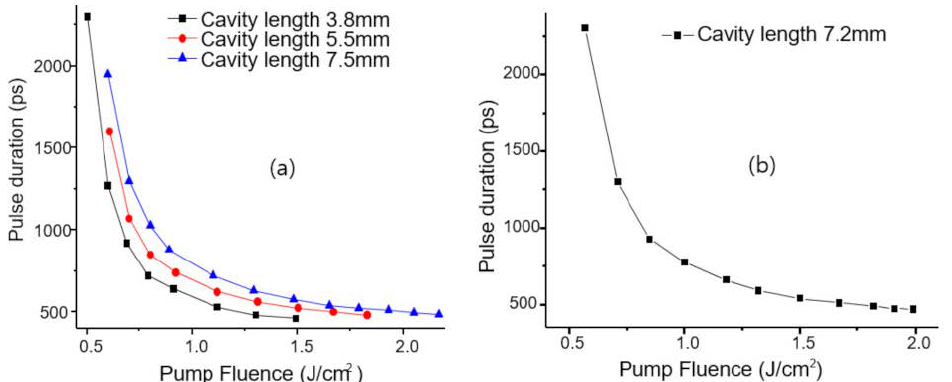
Figure 6. Dependences of the pulse duration T on pump fluence W PUMP for pump spot 3.4 × 3.4 mm ( a ) and 5.6 × 5.6 mm ( b ). Reprinted with permission from ref. [17]. Copyright 2019 © The Optical